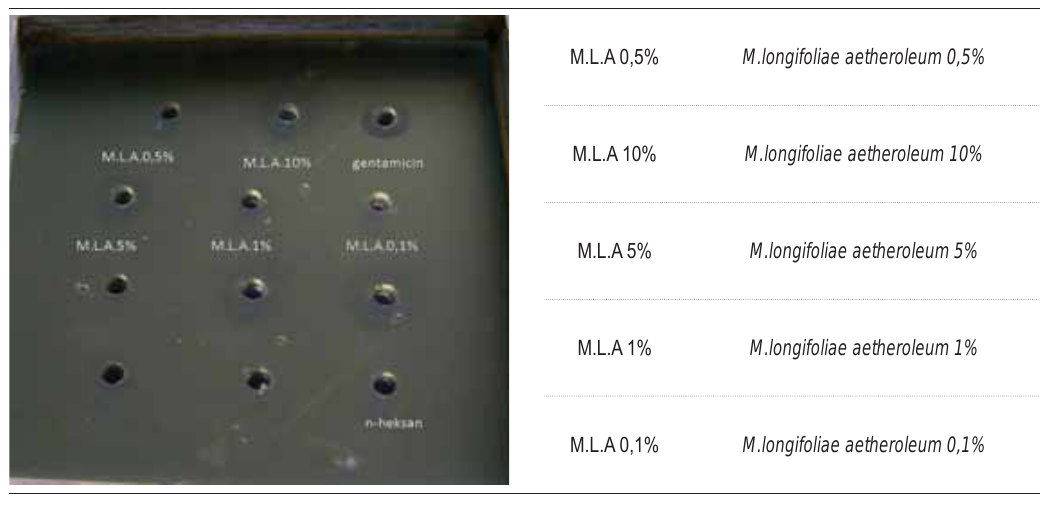
FIGURE 5. Antimicrobial activity against Escherichia coli